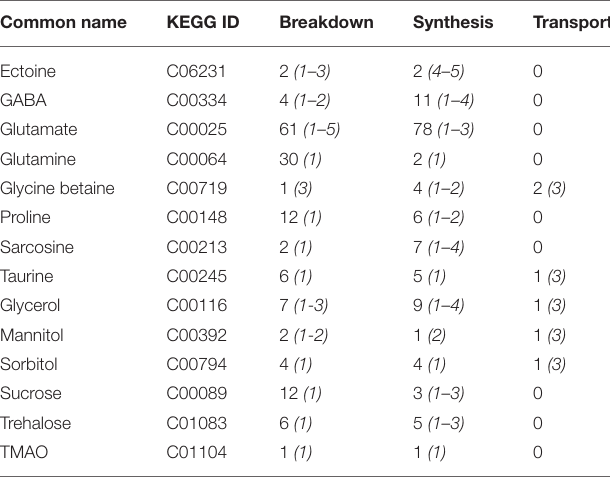
The table includes: Common name of osmolyte, the KEGG ID, the total number of curated pathways with associated KOs used in the searches for breakdown, synthesis, and transport, and the range of steps in each pathway in parentheses. Some pathways required the presence of multiple steps (i.e., KOs) to be considered complete ( Supplementary Material 1 ). A single step value indicates all pathways had the same number of steps. For osmolyte pathways with differing number of steps, a range is reported which reflects the minimum and maximum number of steps for all pathways. GABA = 4-aminobutanoate, TMAO = trimethylamine